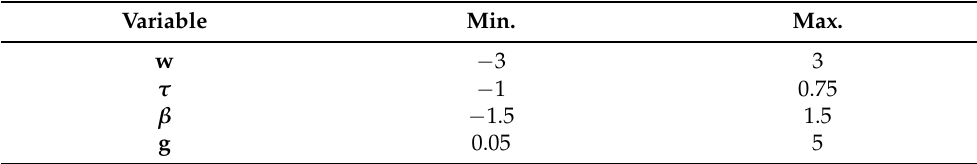
Table 1. Search space constrains of each of the denormalized optimization variables. Variable